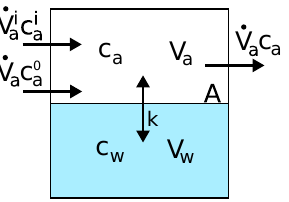
Figure 1. Mass balances for the air and water side. Naming con- vention is as follows: A : water surface area; V a : air volume; V w :